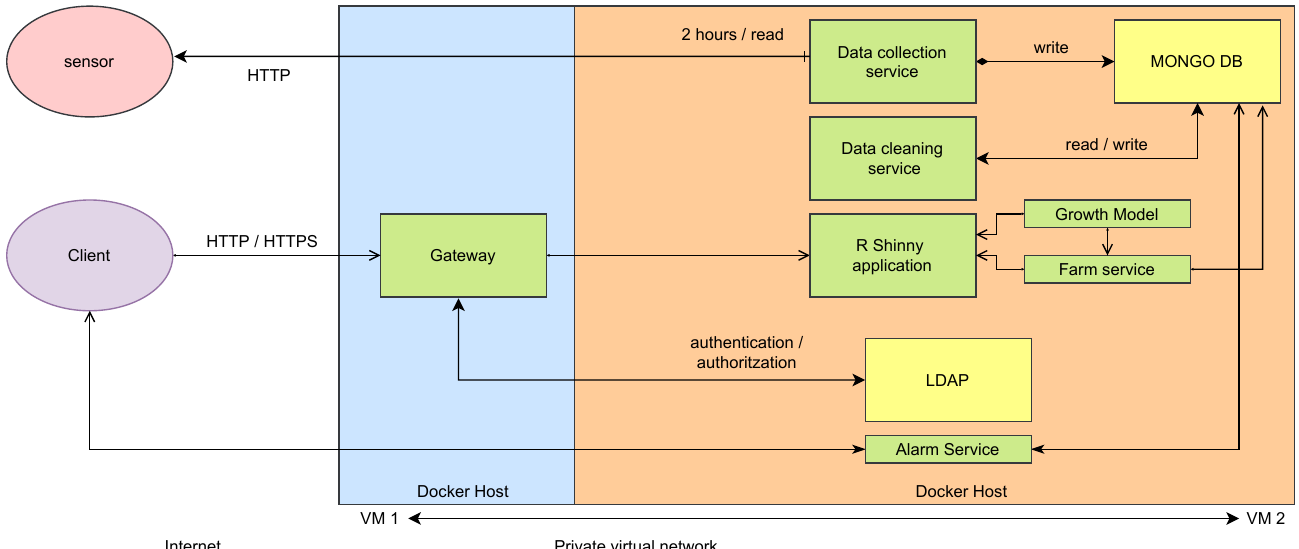
Figure 11. General scheme of the deployment of the case study.